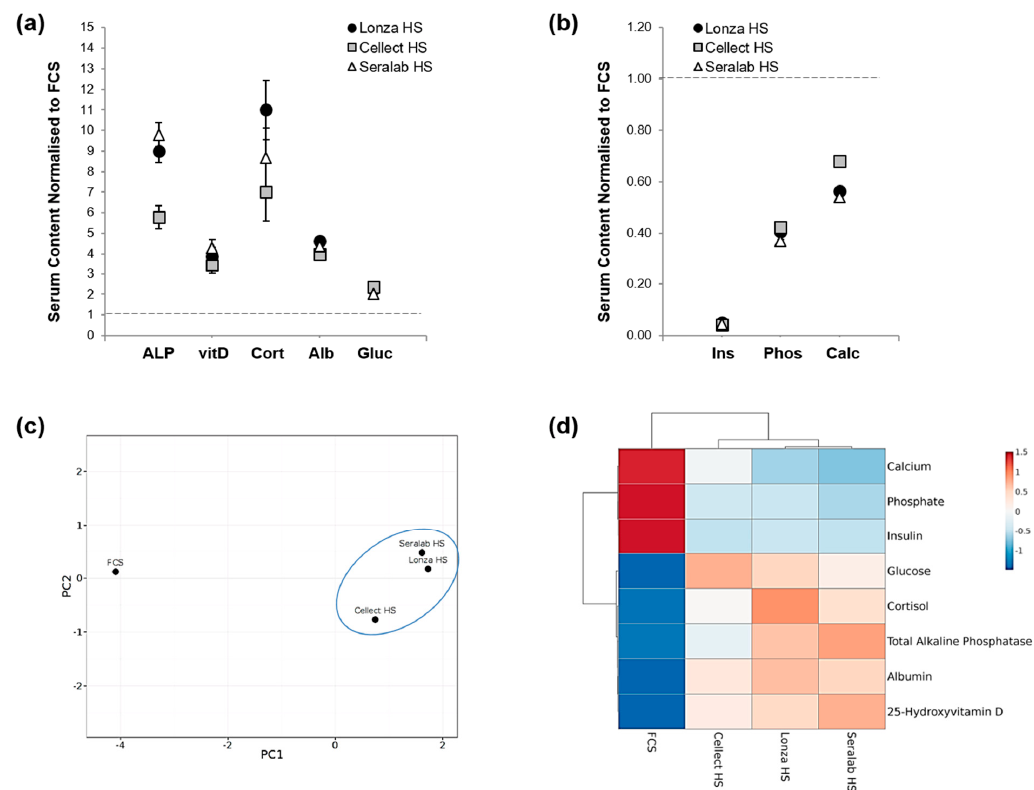
Figure 3. Biochemical analysis of serum components in FCS and HS samples. ( a ) Normalisation to FCS values (dashed line) showed higher HS concentrations for total alkaline phosphatase (ALP), 25-Hydroxyvitamin D (vitD), cortisol (Cort), albumin (Alb), and glucose (Gluc). ( b ) Lower concentrations of insulin (Ins), phosphate (Phos), Calcium (Calc) found in HS samples normalised to FCS (dashed line). * p < 0.05, and **** p < 0.00005 ( n = 3). ( c ) Principal component analysis of the different serum samples analysed. ( d ) Heat map of the serum component analysed showing clustering of human samples.